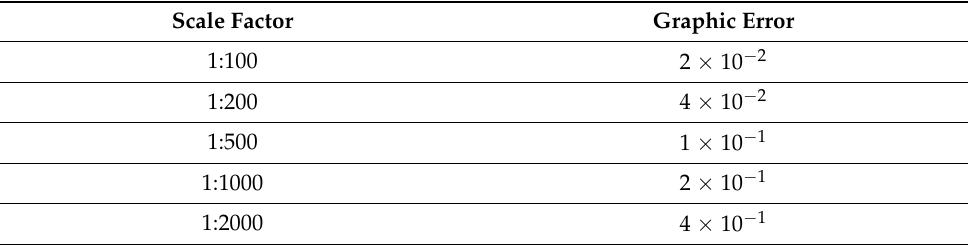
Table 15. Graphic error according to scale